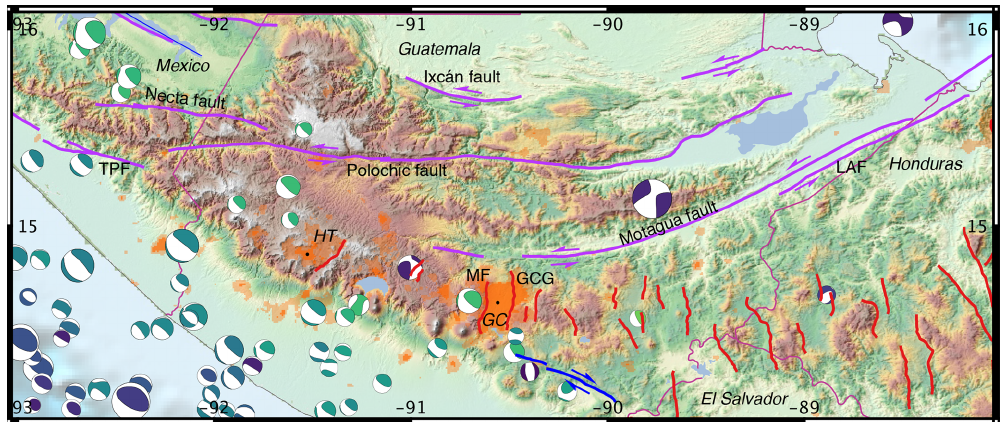
Figure 3. The Motagua–Polochic fault zone. MF is the Mixco fault. GCG is the Guatemala City graben. TPF is the Tonalá–Polochic fault zone. LAF is the Los Amates fault. HT is the Huehuetenango. GC is Guatemala